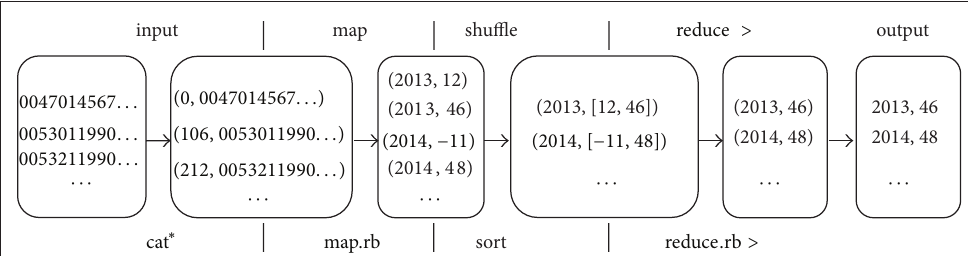
Figure 3: Logical data flow of a simple MapReduce job.